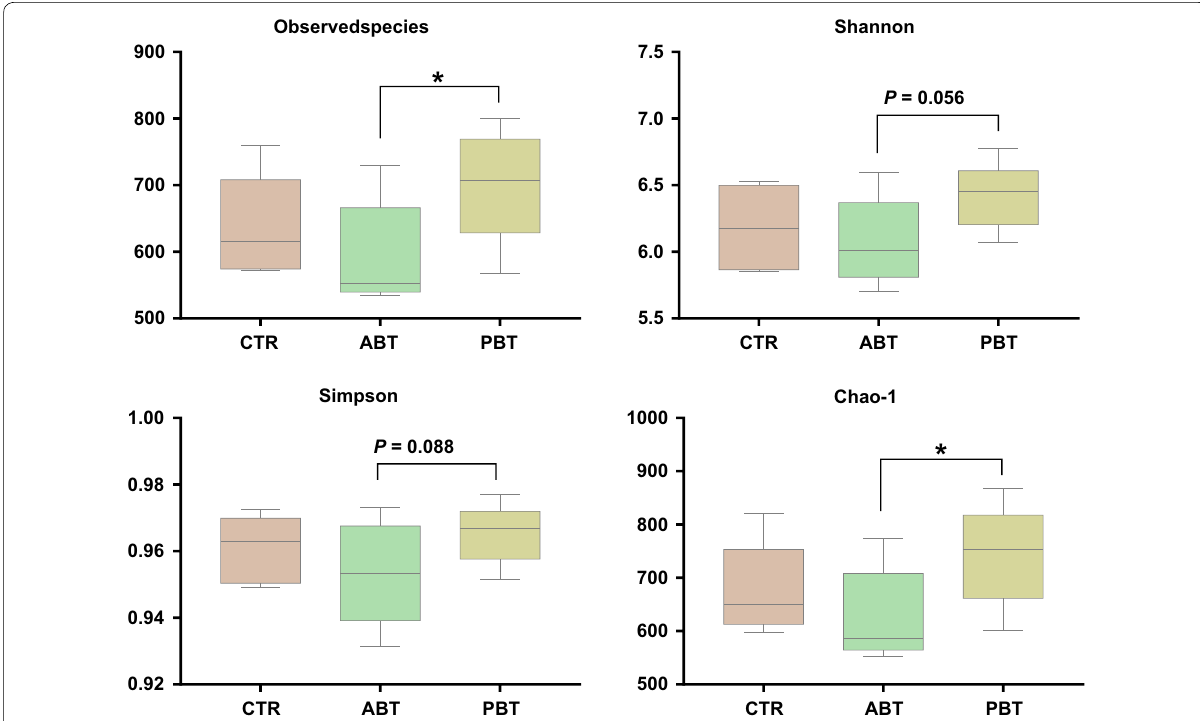
Fig. 1 Effects of dietary B. subtilis supplementation on colonic microbial community diversity of piglets. Data are expressed as mean considered to be significant when P <